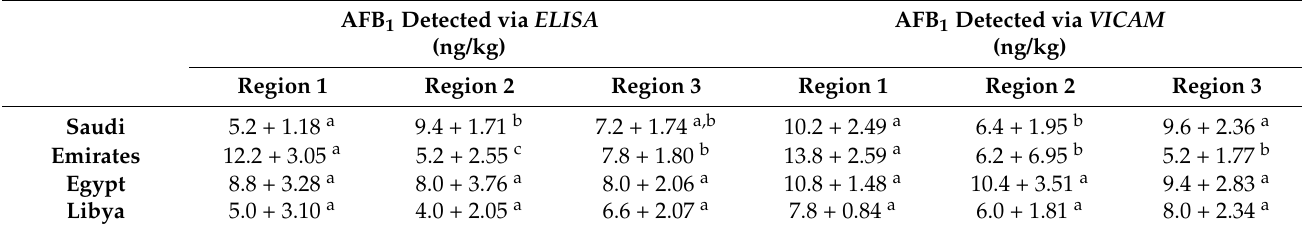
Table 4. Determination of Aflatoxin B 1 in plant feed materials collected from camel pasture areas of the Arabian Peninsula and North Africa.